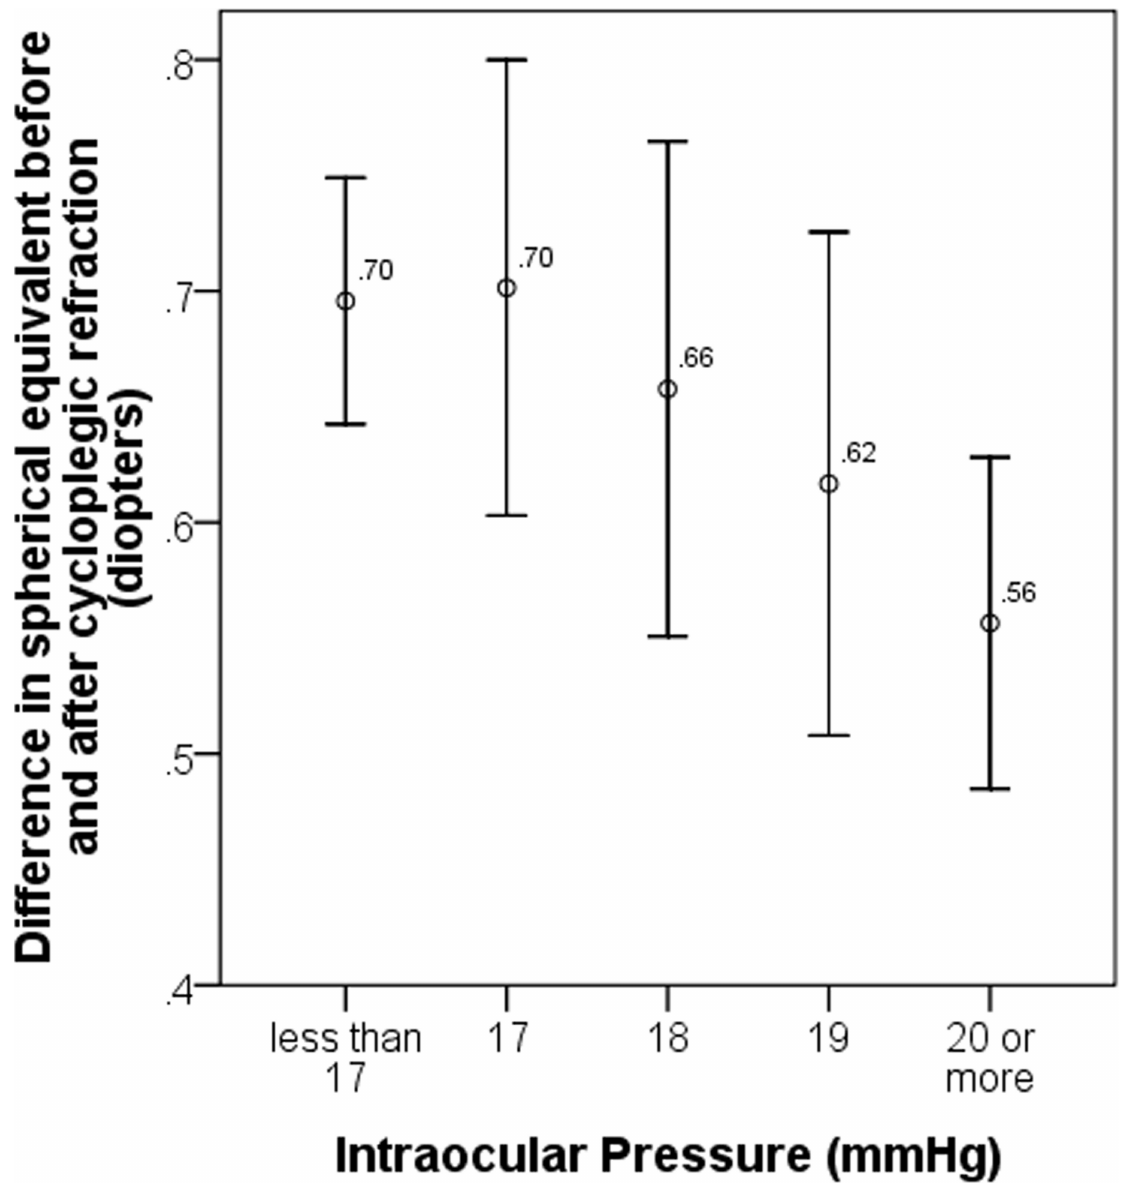
Fig 2. Amount of errors due to non-cycloplegic refraction by intraocular